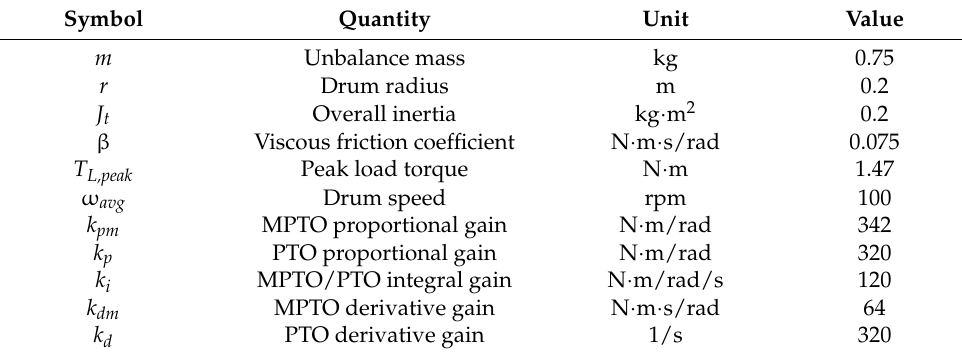
Table 1. Simulated test